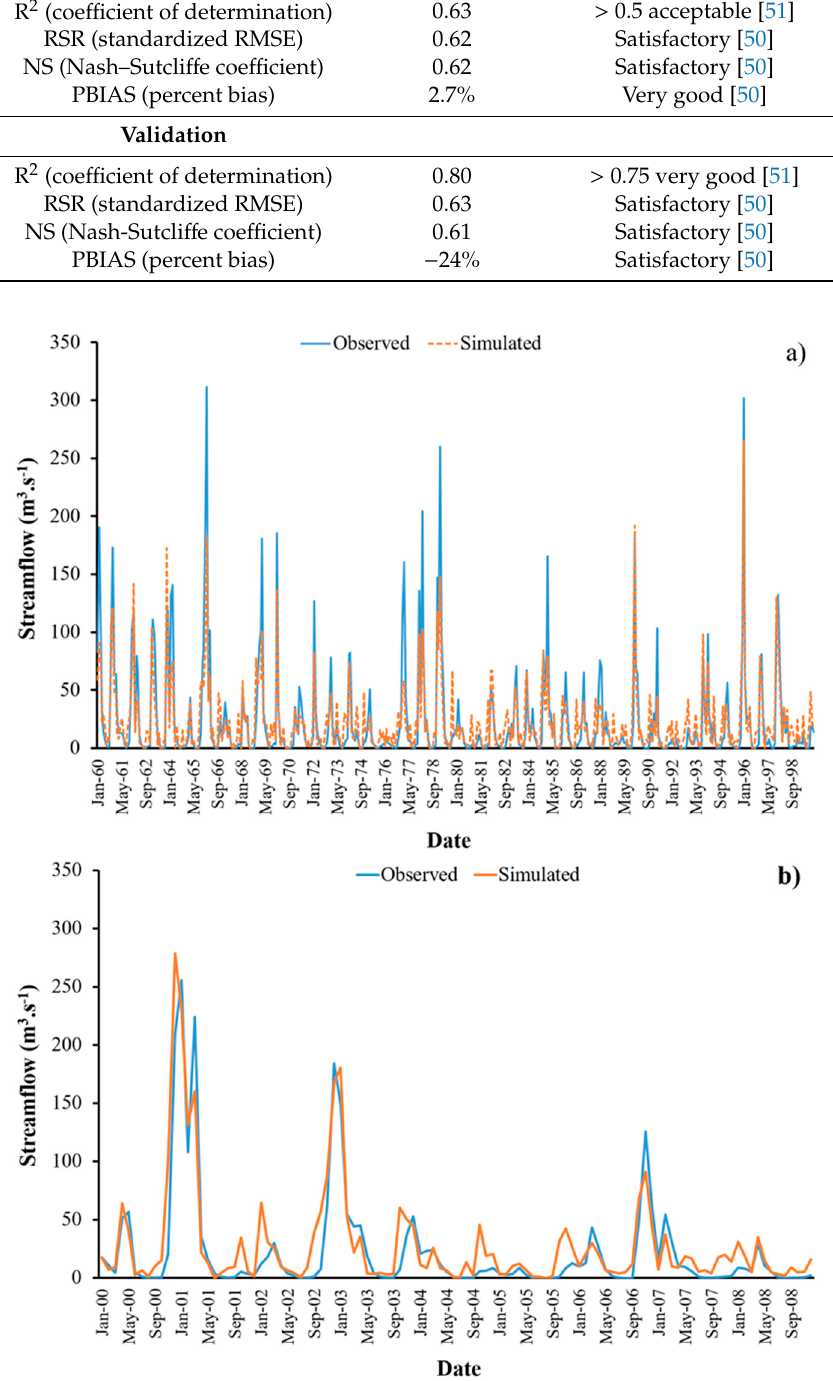
Figure 8. The comparison of observed and simulated streamflow during ( a ) the calibration (between 1960 and 1999); and ( b ) validation (between 2000 and 2008) in the Sabor river basin. The simulation of the streamflow was executed on a daily basis, but for best visualization was present on a monthly basis.